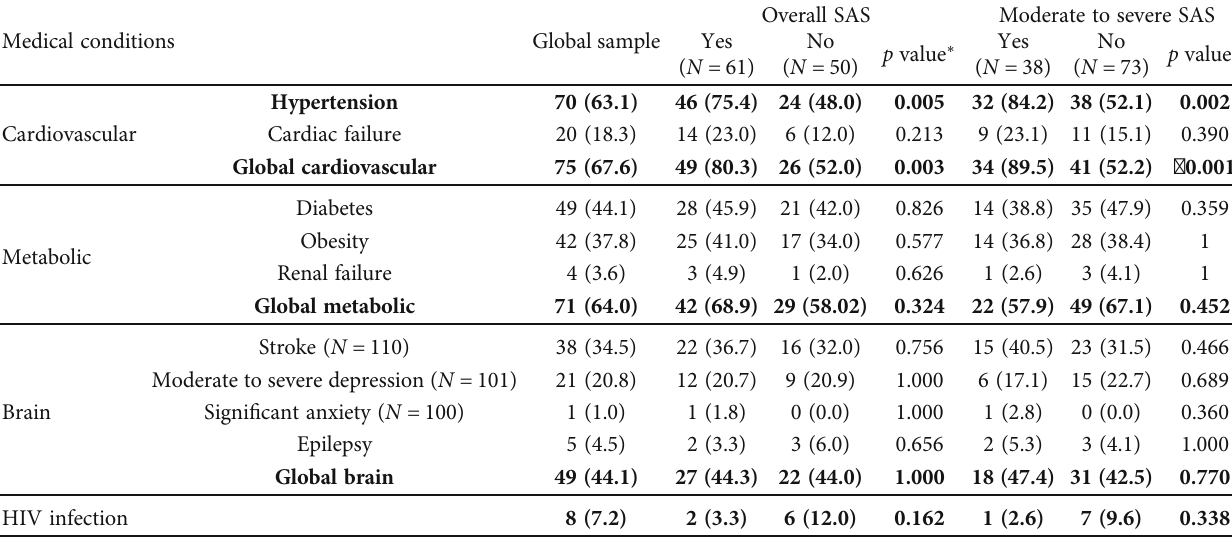
Figure 1: Prevalence of sleep apnea syndrome in patients with some comorbidities, hospitalized in Yaoundé Central Hospital, November 2016 – May 2017, Yaoundé, Cameroun. N = 111 . For each condition, SAS prevalence is given with its 95% con fi dence interval. Table 3: Frequencies of medical conditions (cardiovascular, metabolic, brain, and HIV infection) among patients with clinical sleep apnea syndrome, hospitalized in Yaoundé Central Hospital, November 2016 – May 2017, Yaoundé, Cameroun. N = 111